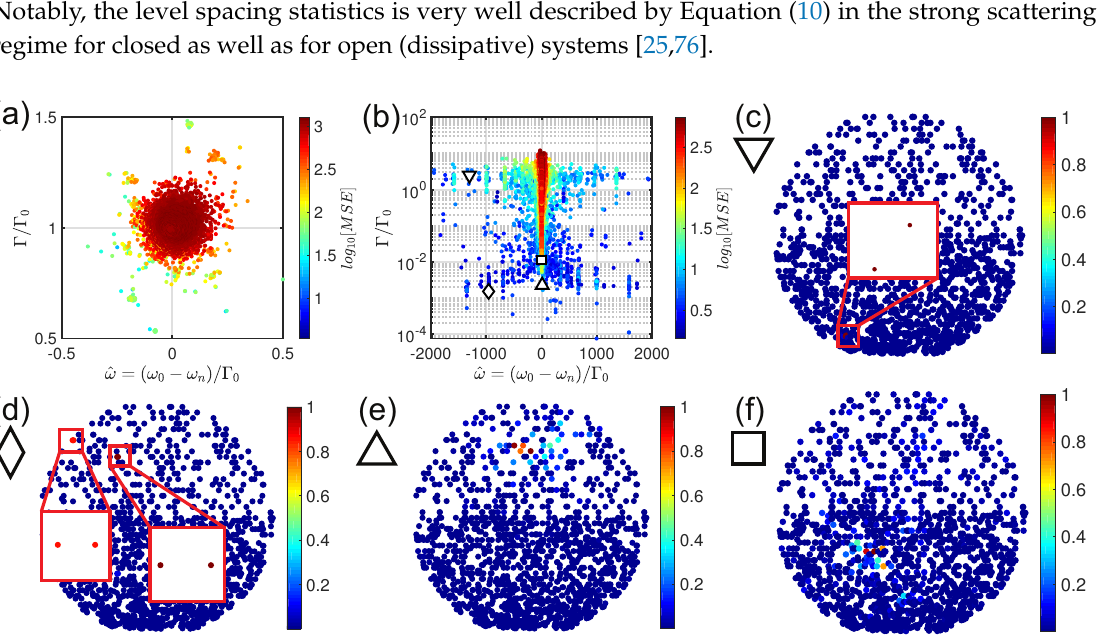
Figure 9. Panels ( a , b ) display the complex eigenvalues distributions of a representative EC DL configuration (integer starting point equal to W = ( 379;1735 ) on the elliptic curve defined by the equation y 2 = x 3 + 27 x + 4 defined over the finite field F 2111 ) of the Green’s matrix (7) for two different optical densities, respectively. The data are colored according to the log values of the MSE. The 10 different markers in panel ( b ) identify representative scattering resonances displayed in panels ( c – f ). In particular, panels ( c , d ) display , respectively, a proximity and a clustered scattering resonance on 4 particles, while panels ( e , f ) show two representative modes with the lowest decay